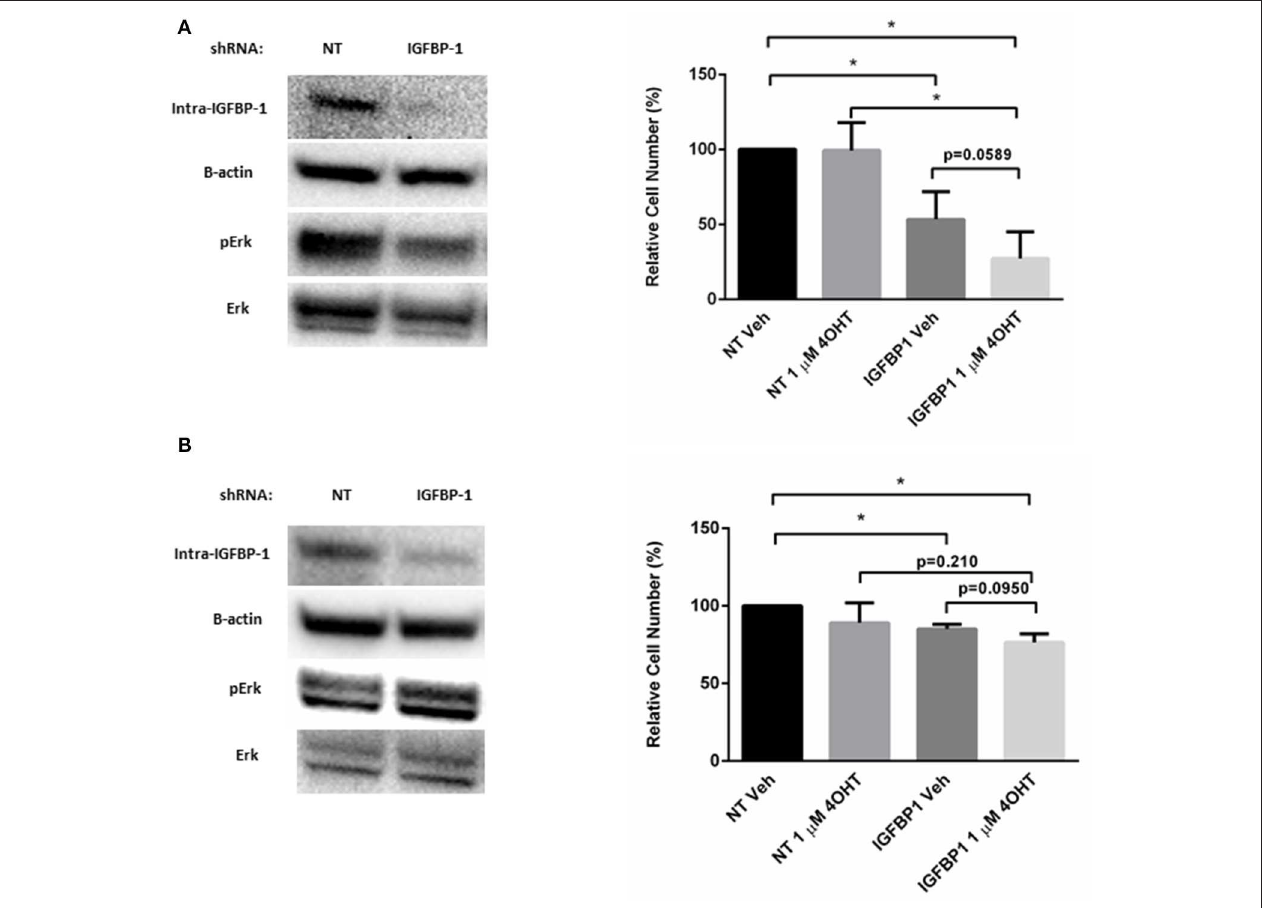
FIGURE 7 | Knockdown of IGFBP-1 restores 4-OHT sensitivity in breast cancer cells. (A) Immunoblot analysis of IGFBP-1, phospho-Erk, and Erk after transfected with non-targeting (NT) shRNA or IGFBP-1 shRNA in MCF7-TamR (left); measurement of relative cell number (%) in MCF7-TamR after transfected with NT shRNA or IGFBP-1 shRNA and treated with either vehicle or 1 µ M 4-OHT (right). (B) Immunoblot analysis of IGFBP-1, phospho-Erk, and Erk after transfected with non-targeting (NT) shRNA or shRNA for IGFBP-1 in T47D-TamR (left); measurement of relative cell number (%) in T47D-TamR after transfected with NT shRNA or IGFBP-1 shRNA and treated with either vehicle or 1 µ M 4-OHT (right). Results are the average of 3 independent experiments, and error bars are the standard error of the mean. * p <